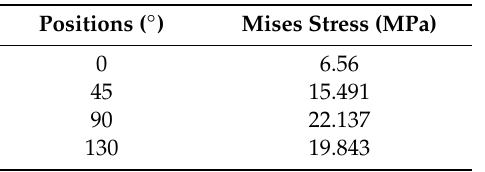
Table 2. Maximum stress at di ff erent rotating positions of the upper arm.